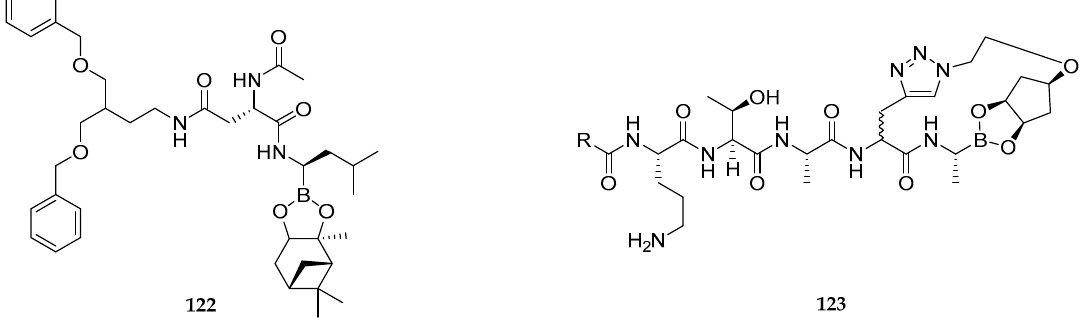
Figure 12. Boronic esters as promising compounds in Medicinal Chemistry. 122 : Selective proteasome inhibitor and apoptotic agent; 123 : Antibacterial agent against E. coli , P. aeruginosa , K. pneumoniae , and S. aureus .